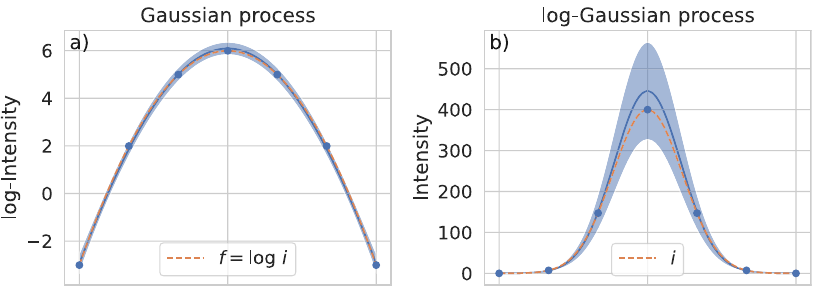
blue line). b Corresponding log-Gaussian process. As expected from Eq. (5), max- imizing the uncertainty of the log-Gaussian process enables to fi nd regions of